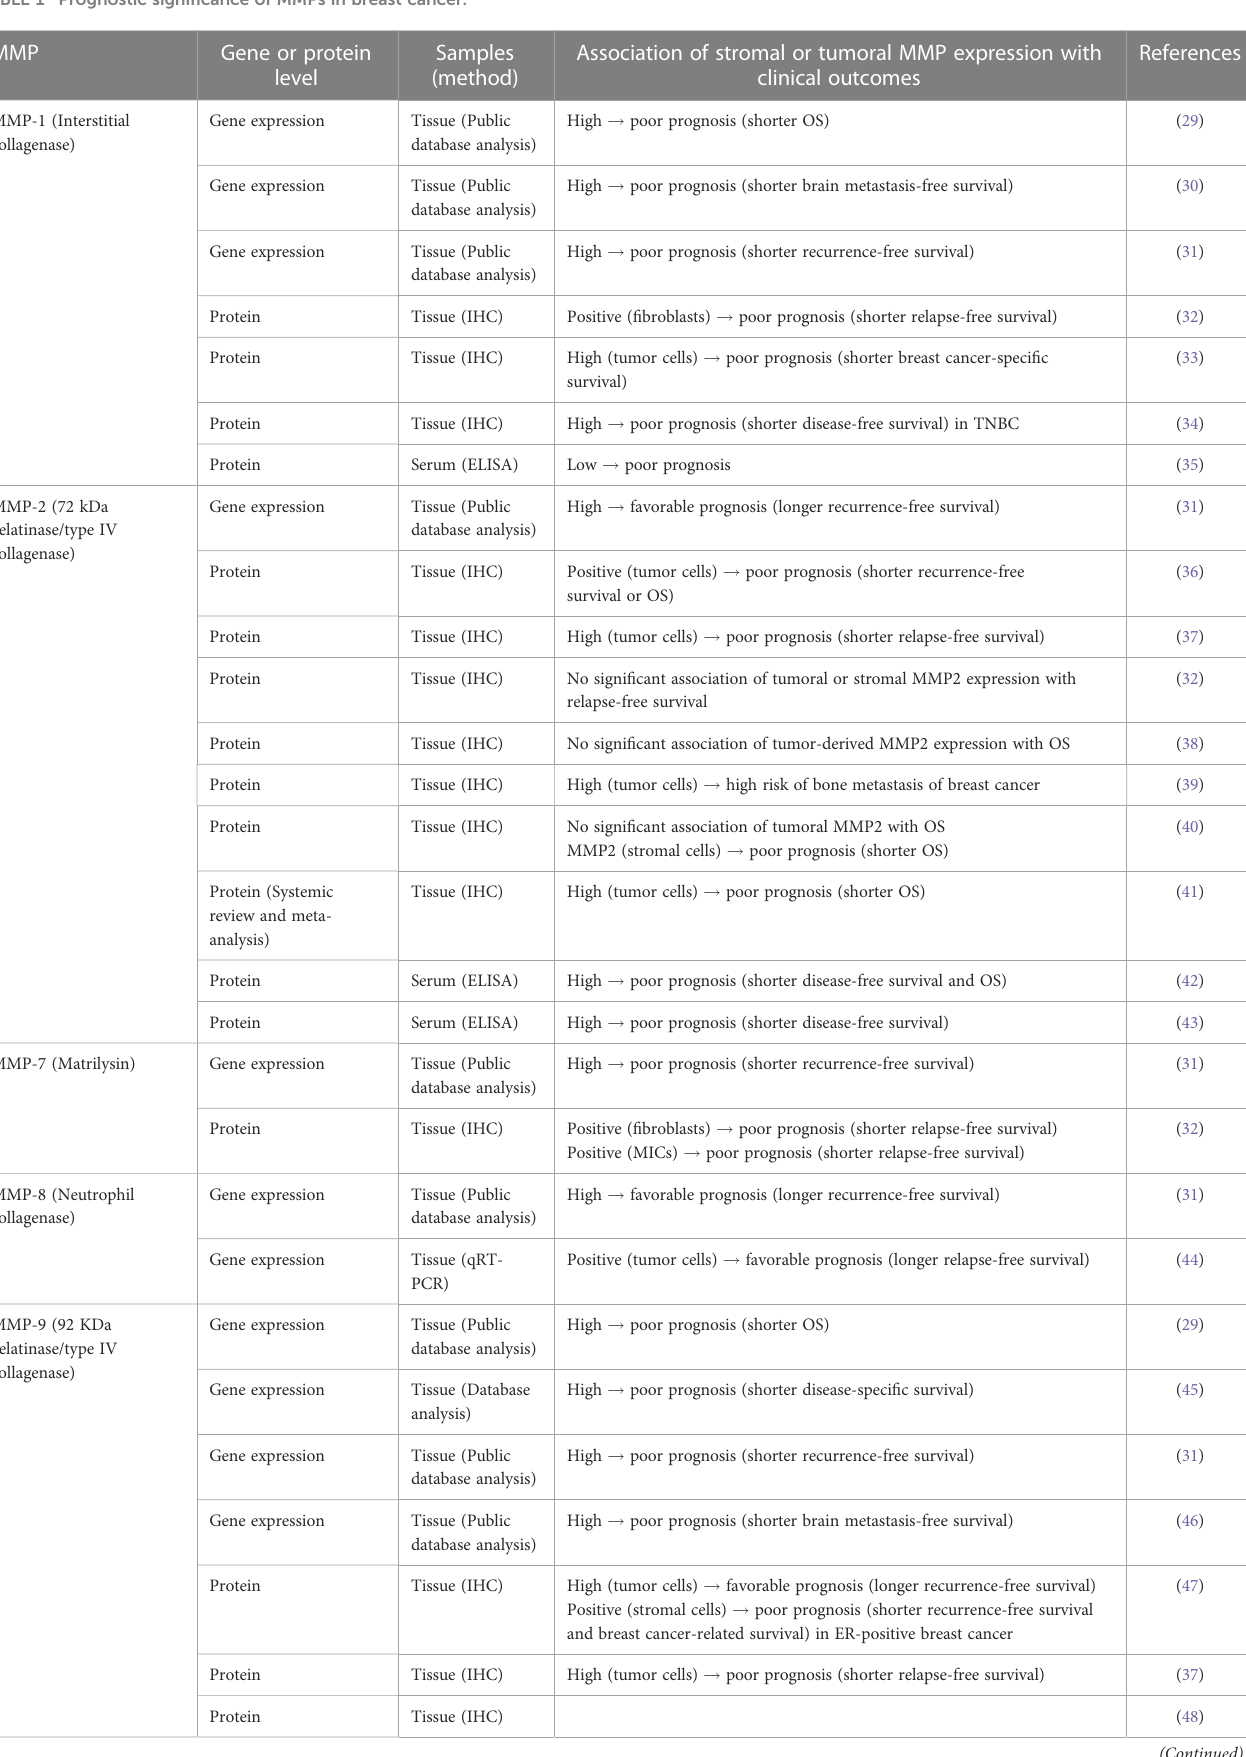
TABLE 1 Prognostic signi fi cance of MMPs in breast